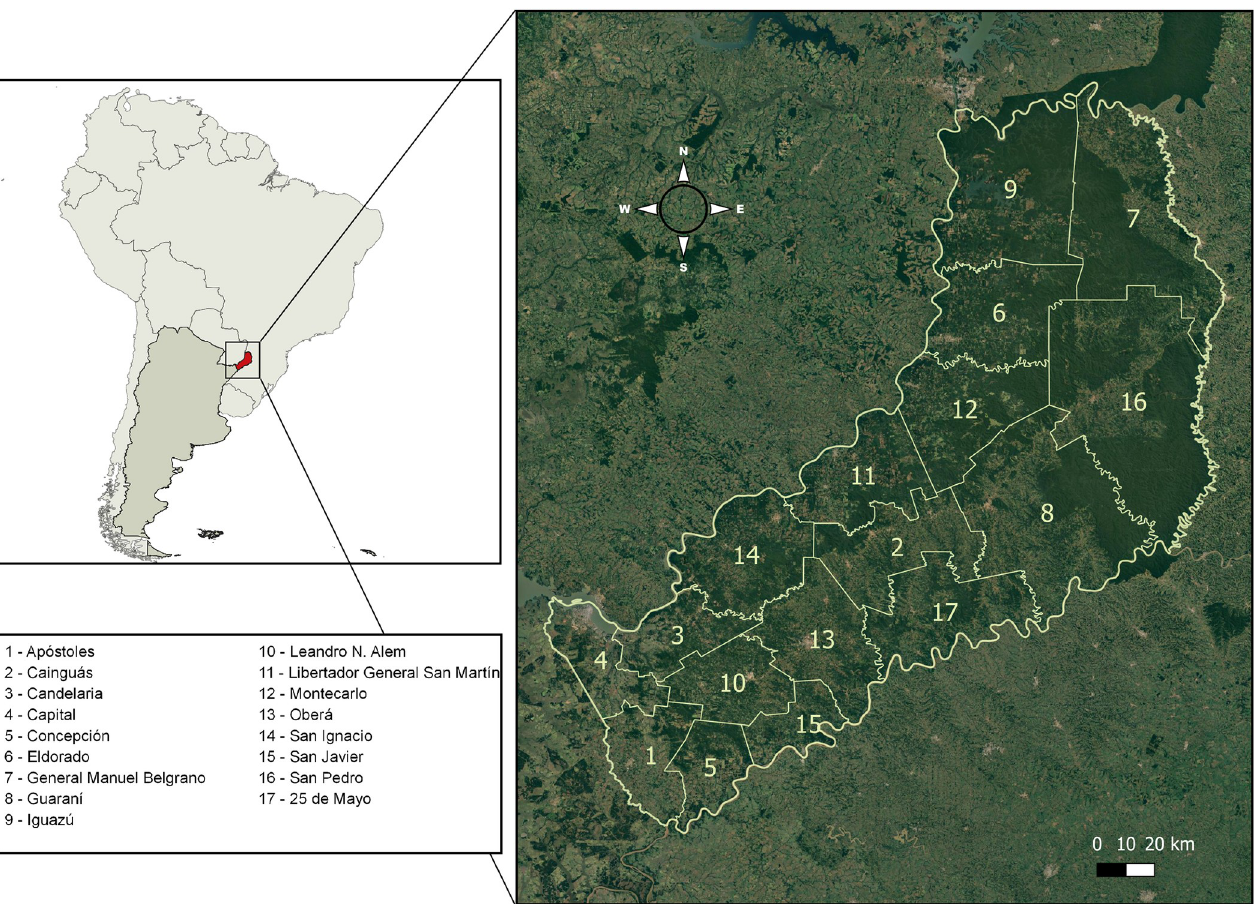
Fig 2. Study area, including the location of Misiones in South America and the distribution of the 17 departments within the province. The map was constructed in the QGIS 3.10.4-A Coru ñ a, with layers downloaded from the National Institute of Geography (https://www.ign.gob.ar/NuestrasActividades/